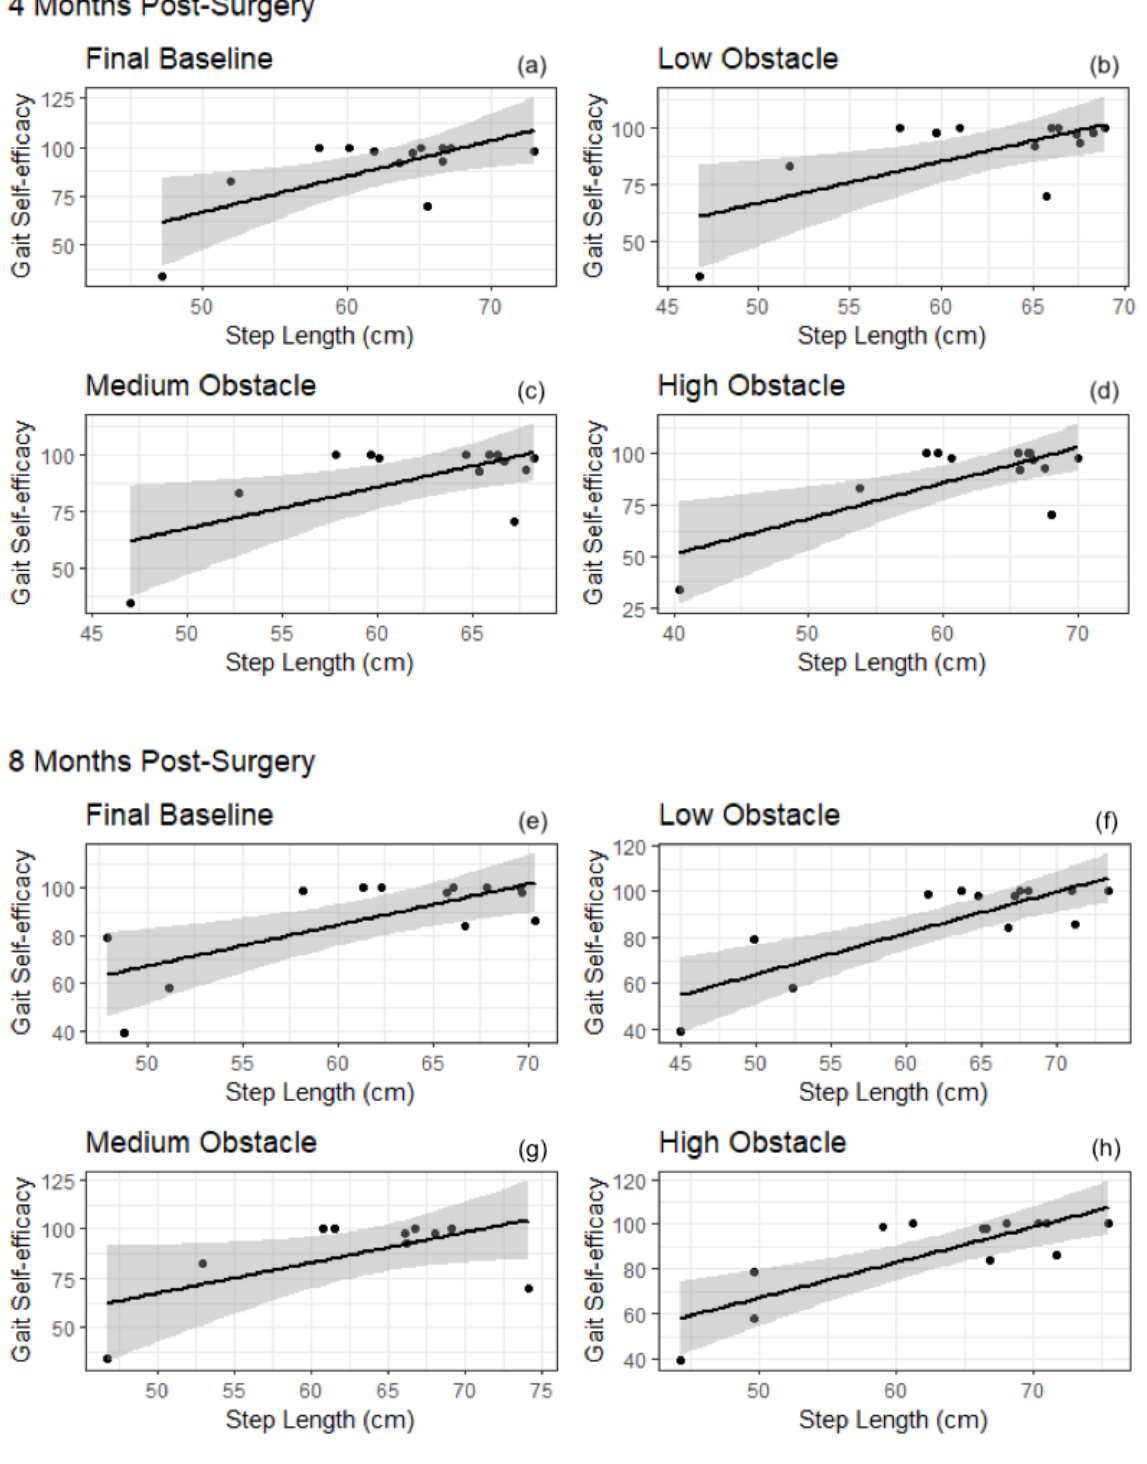
Figure 1. Correlations between gait self-efficacy and step length for final baseline ( a , e ), low obstacle ( b , f ), medium obstacle ( c , g ), and high obstacle conditions ( d , h ) after bariatric surgery. Gait self-efficacy were significantly associated with step length in all conditions. A general linear model was used to fit the trend lines. Clouds represent 95% CI.